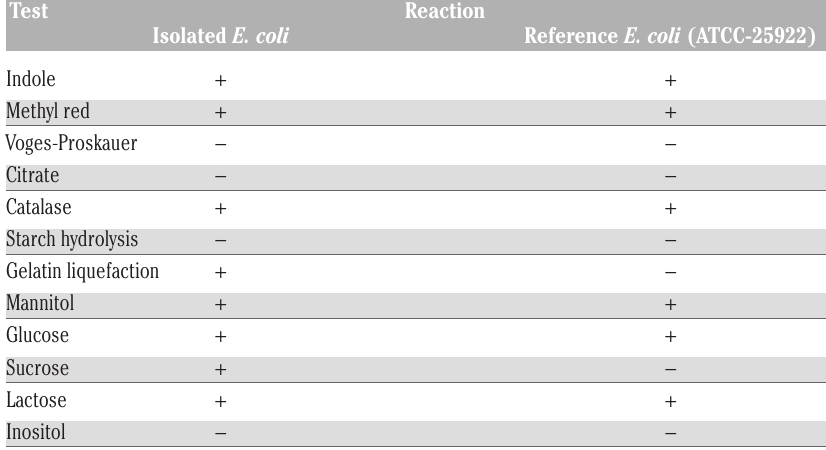
Table 3. Biochemical characteristics of E. coli isolated from Staff Club swimming pool, OAU, Ile-Ife (Nigeria).